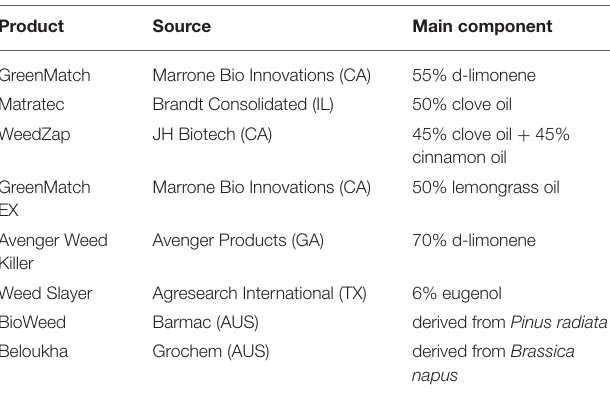
TABLE 5 | Currently available commercially formulated organic herbicides based on essential oils or plant extracts (196,